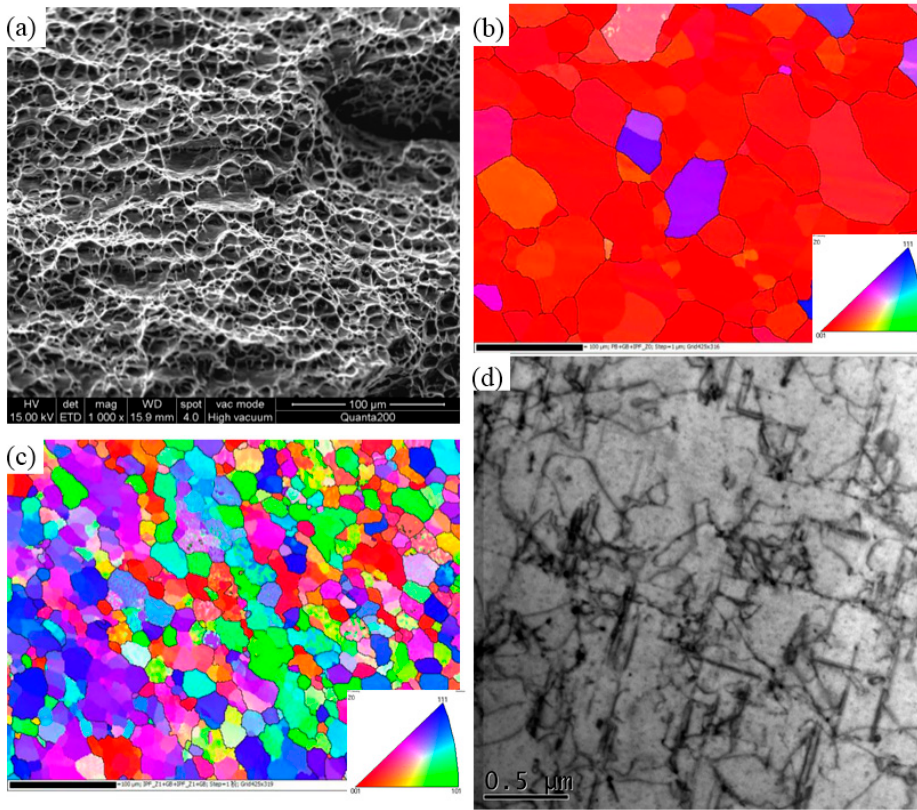
Figure 11. ( a ) Fracture surface and ( b , c ) the OIM of HAZ, TMAZ, respectively; ( d ) TEM picture of heat-affecting-zone (HAZ) of fracture area.